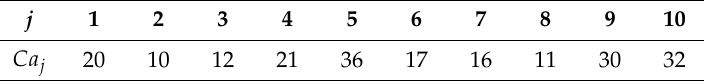
Table 6. The purchasing cost of components at level